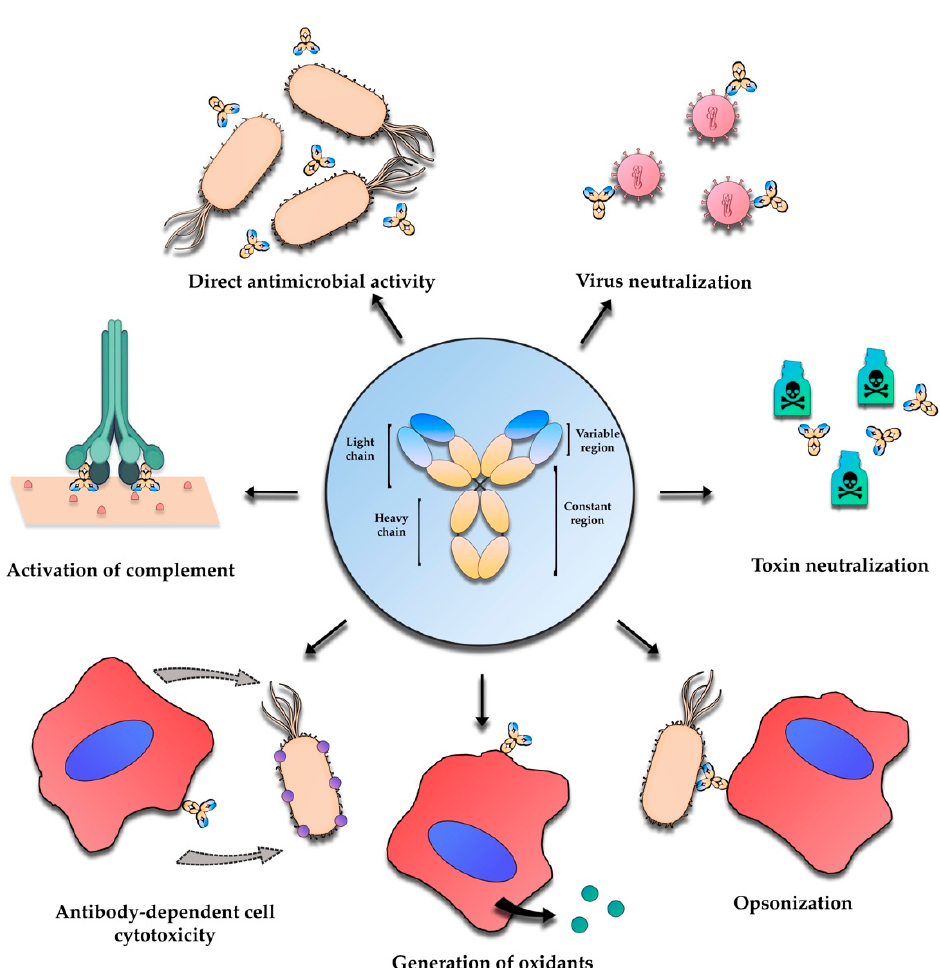
Figure 1. Biological roles played by antibodies. Opsonization and antibody-dependent cell cytotoxicity are dependent of mediators and host cells, while direct antimicrobial activity, generation of oxidants, complement activation, and virus and toxin neutralization are independent of other components of the immune system.